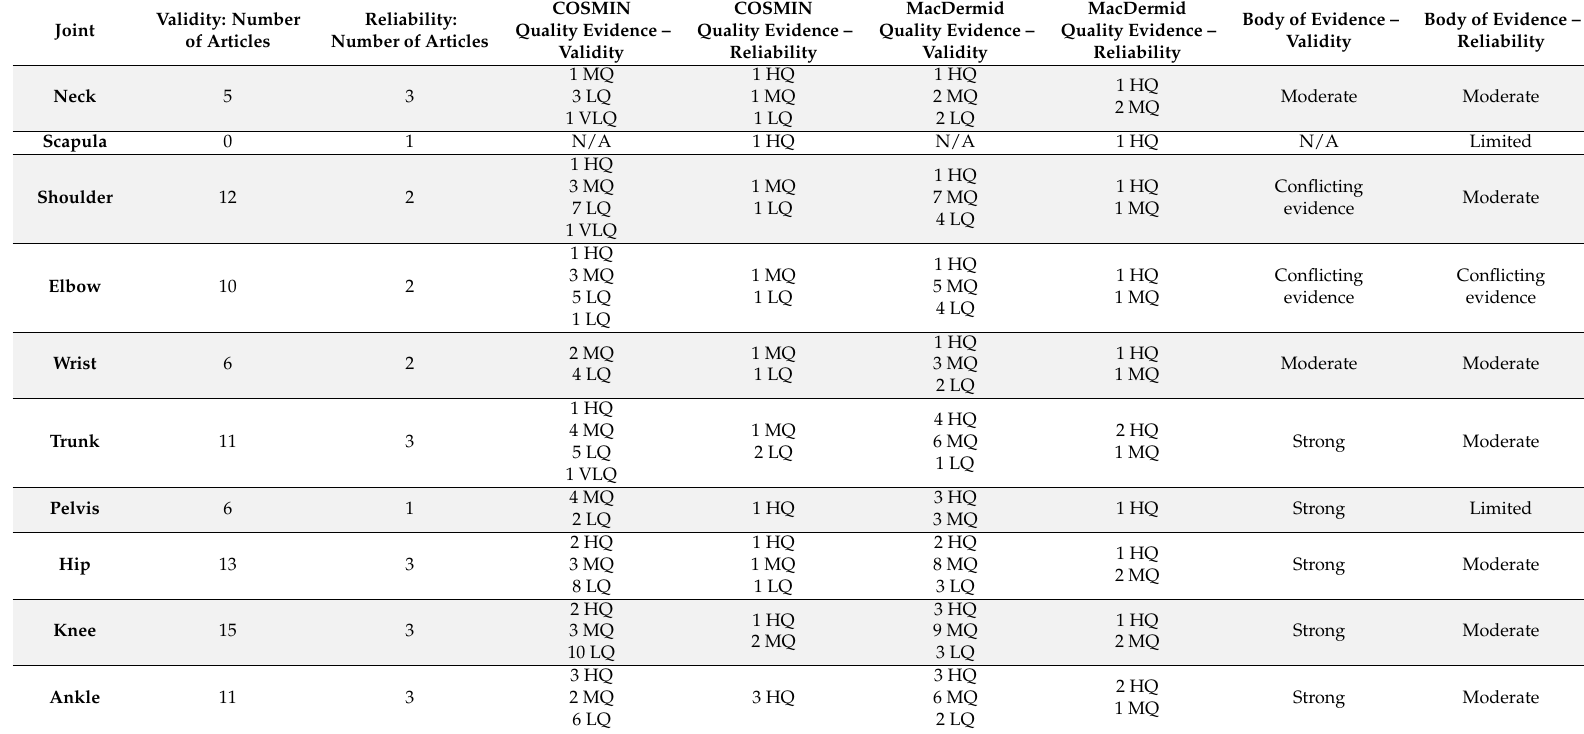
Table 1. Synthesis of overall quality and body of evidence by